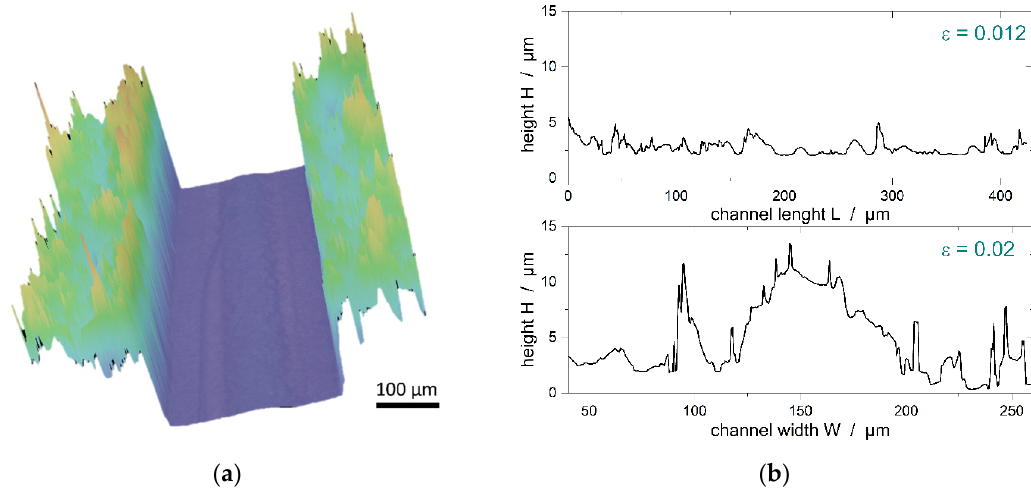
Figure 3. ( a ) Microscopic three-dimensional record of the microfluidic channel. ( b ) Roughness along the channel length (top) and width (bottom). ϵ indicates the relative roughness.